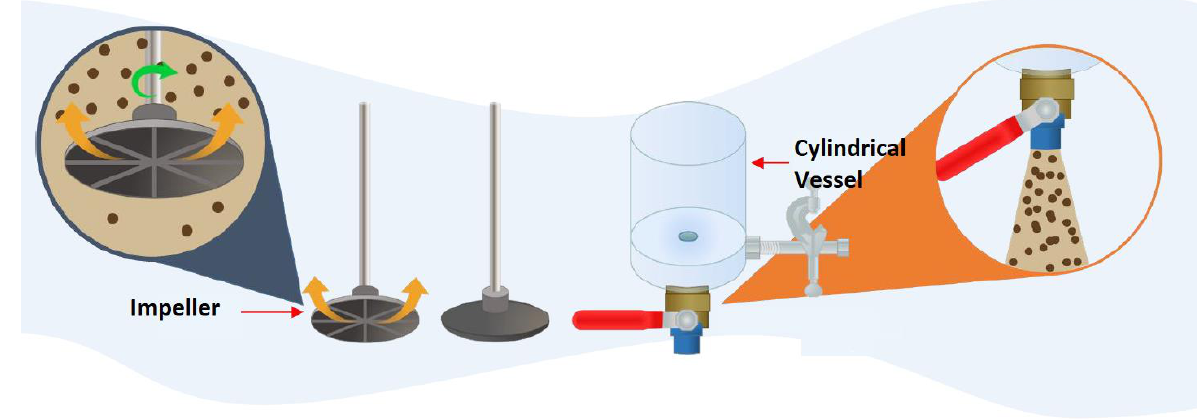
Figure 4. Schematic representation of experimental setup for settling tests.